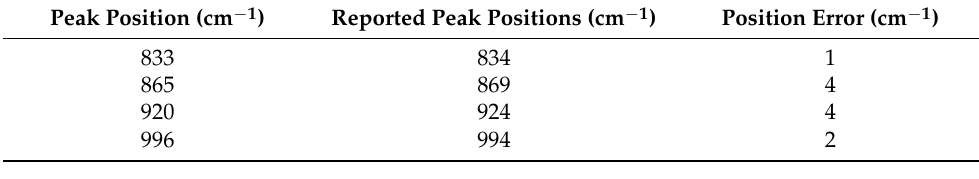
Table 1. Absorption peak signatures of FTIR spectroscopy of sucrose as indicated by Figure 4. Peak Position (cm − 1 )